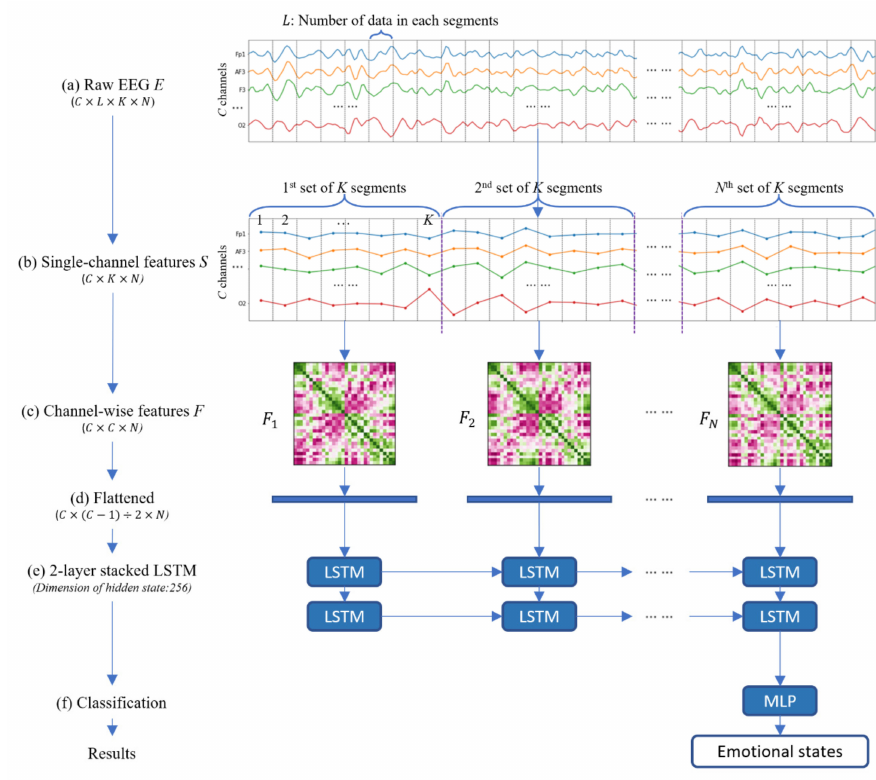
Figure 1. The architecture of our model. ( a ) Raw electroencephalogram (EEG) signals E . ( b ) Single- channel features S . ( c ) Channel-wise features F . ( d ) Flattened vector of channel-wise features. ( e ) Architecture of two-layer stacked Long Short-Term Memory (LSTM). ( f ) Emotion classification using Multi-Layer Perceptron